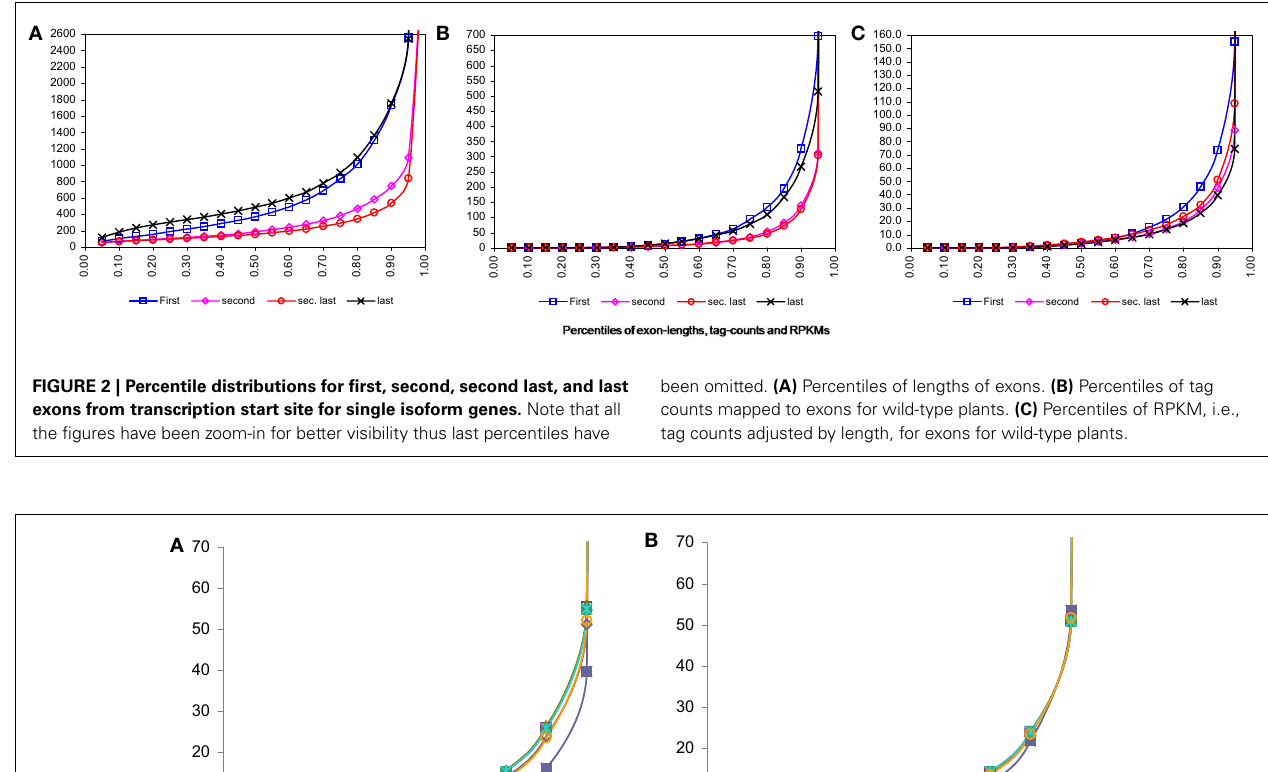
Stress; LS, High-light Stress; SS, Salt Stress. (A) Percentiles of expression with global normalization. (B) Percentiles of expression with percentile